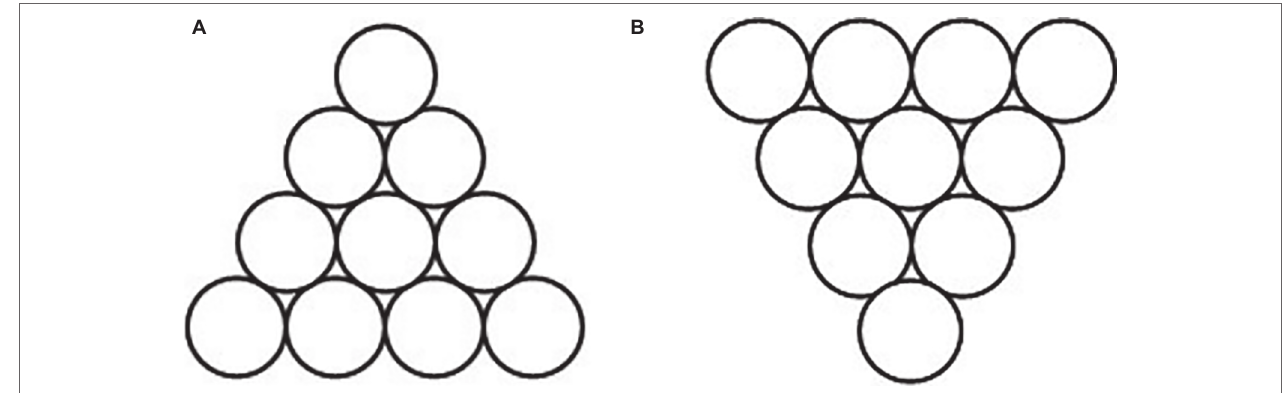
FIGURE 1 | Sample of “Triangle of Circles” problem. Initial state of insight problem (A) and target state of insight problem (B)